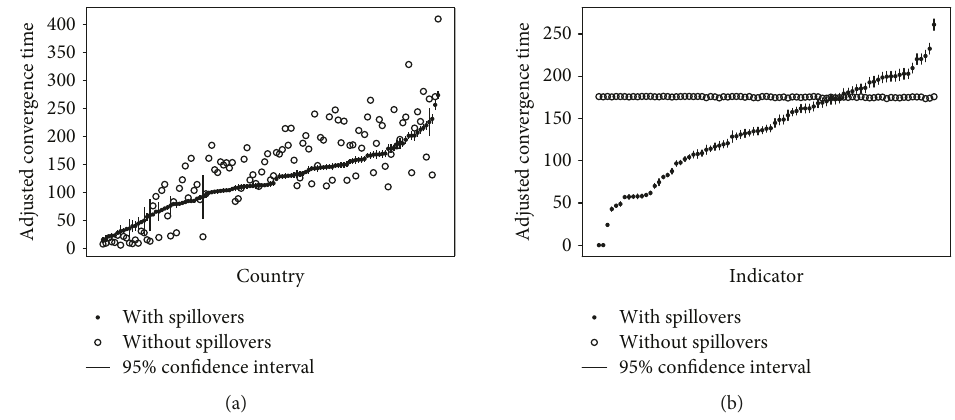
Figure 5: Estimations for the adjusted convergence times in models with and without spillovers. (a) Aggregation by country (sorted by T ). (b) Aggregation by indicator (sorted by T ).